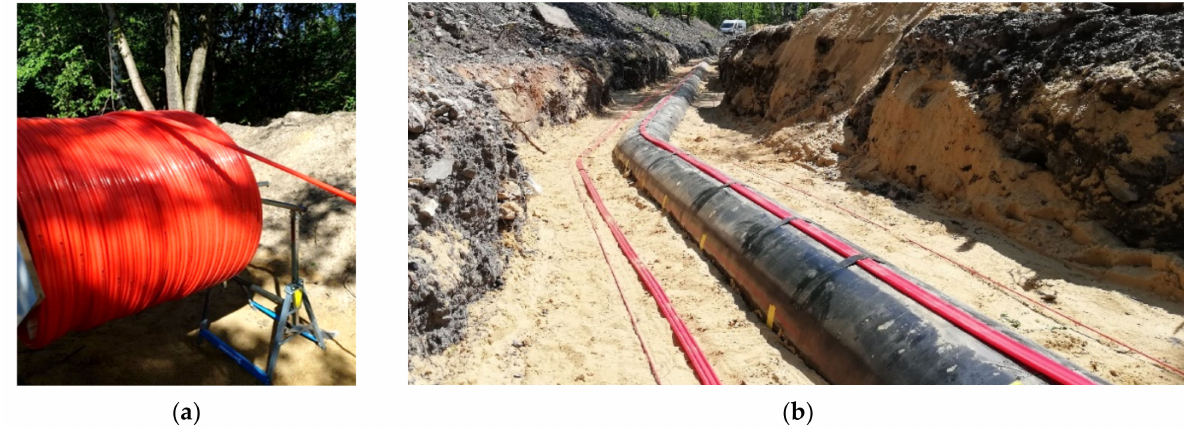
Figure 30. Gas pipeline equipped with 3DSensors: ( a ) delivery on site in the coil; ( b ) view of the installed sensors.